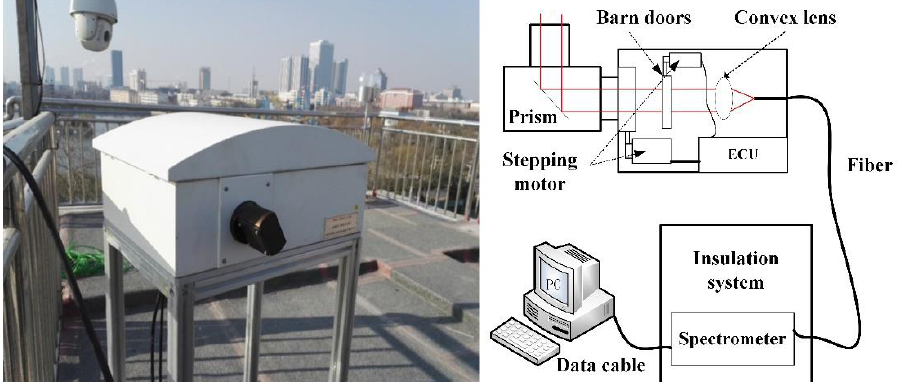
Figure 2. Photograph of the study site at the Environmental Monitoring Center, Cangzhou, and schematic of the MAX-DOAS spectrometer. ECU: Electronic Control Unit. (The left figure was credited by Liang Xi, one of the authors.)